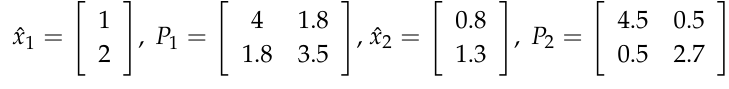
Table 1. Fused result and average computation time of different ellipsoidal methods.